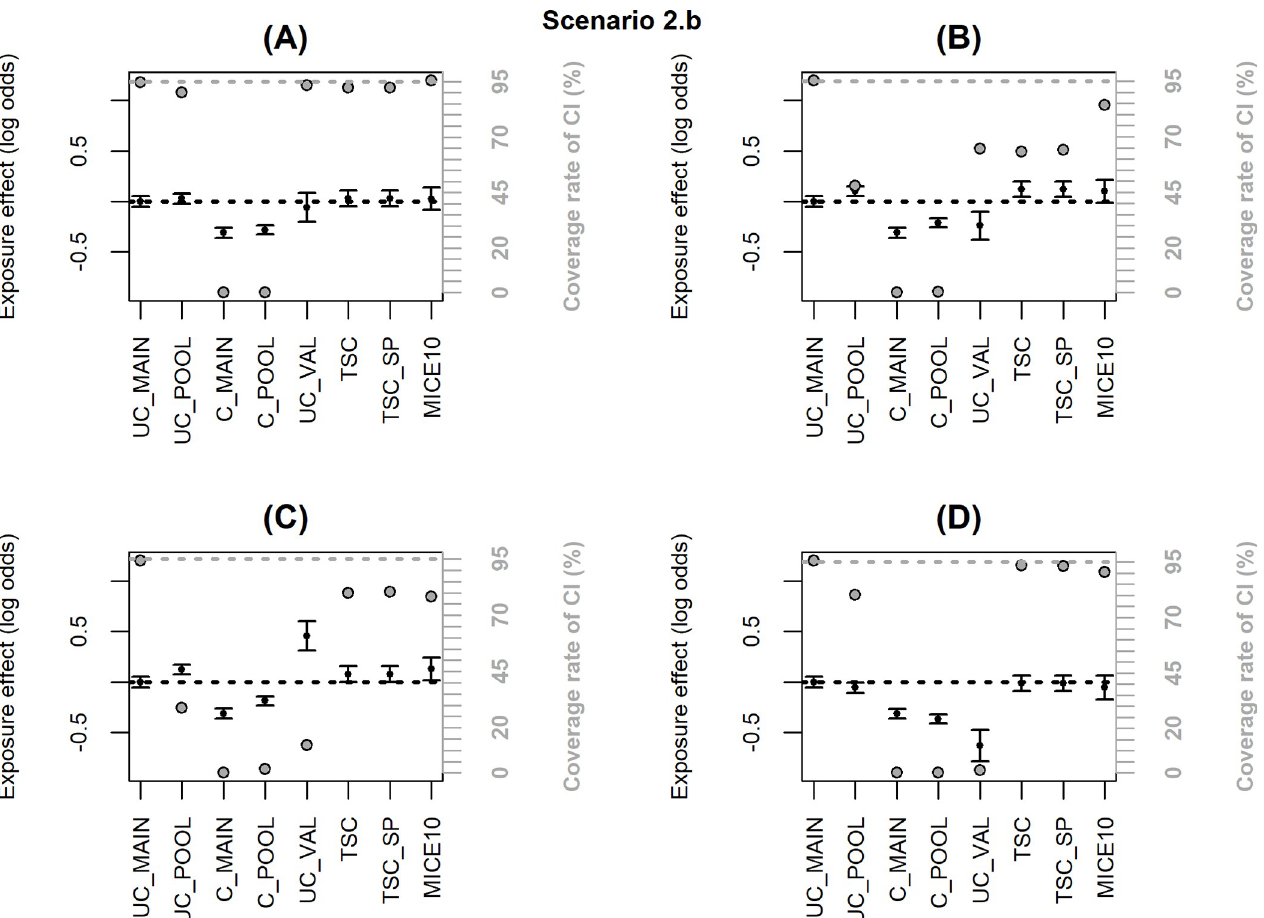
Fig 4. Simulation results when the inclusion probability in the external validation sample (notated P) depends on X + Y or X � Y (scenario 2.b); coverage rate of 95% confidence interval (grey dot with black margin) and mean estimated log-odds ratio for the exposure effect (black dot) ± empirical standard error: (A) logit(P) = -2.6+log(2) X +log(2) Y , (B) logit(P) = -3.2+log(4) X +log(4) Y , (C) logit(P) = -2.7+log(2) X +log(2) Y +log(2) X � Y , (D) logit(P) = -2.5+log(2) X +log(2) Y -log(2) X � Y . The grey dotted line corresponds to the nominal value of the coverage rate of the 95% confidence interval. The black dotted line is the true value of β (0).